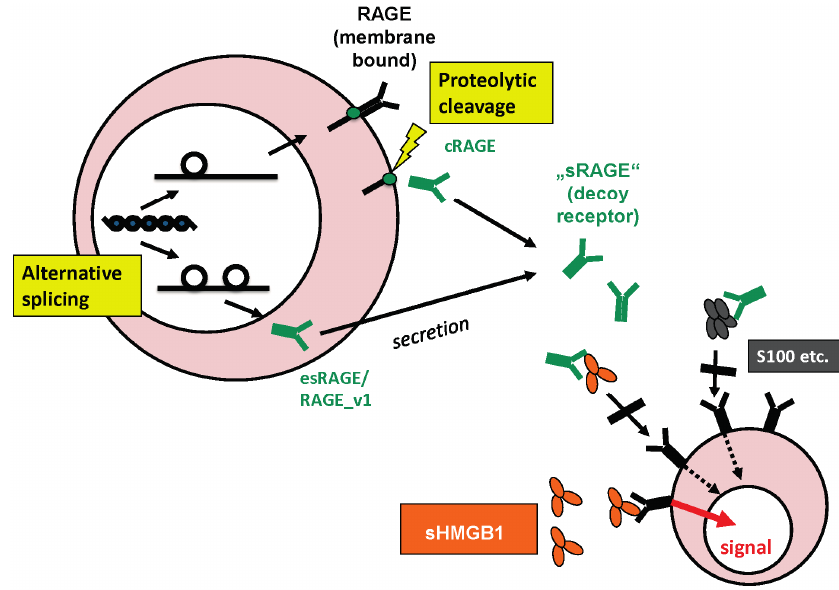
Figure 1. Origin and functions of sRAGE: sRAGE can derive from alternative splicing or proteolytic cleavage of the outer membrane domain of the full-length transmembrane receptor. In the extracellular space, sRAGE can act as decoy receptor for HMGB1 and other